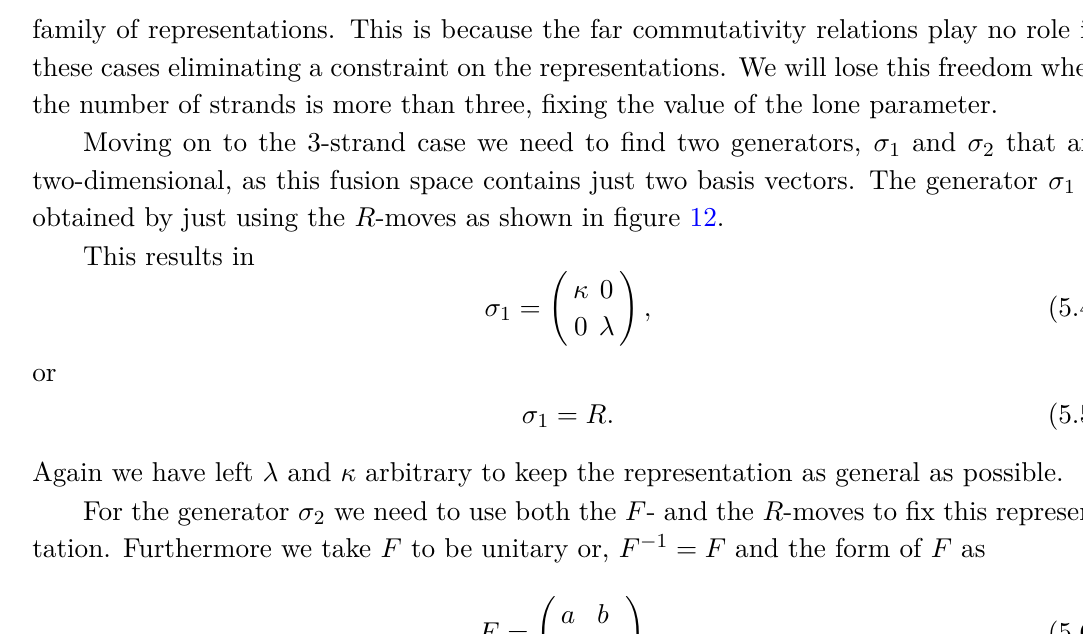
= κ and R ττ = λ τ 1